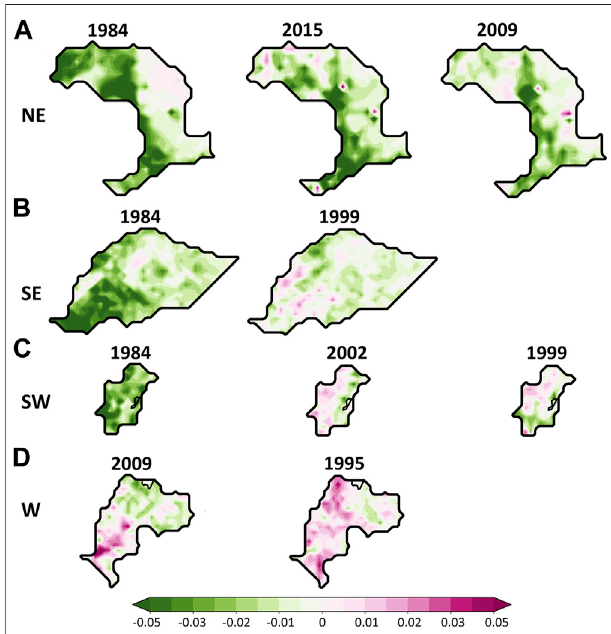
FIGURE 11 | Anomalies in the normalised difference vegetation index (NDVI) for the NE (A) , SE (B) , SW (C) , and W (D) regions under study during severe and extreme drought